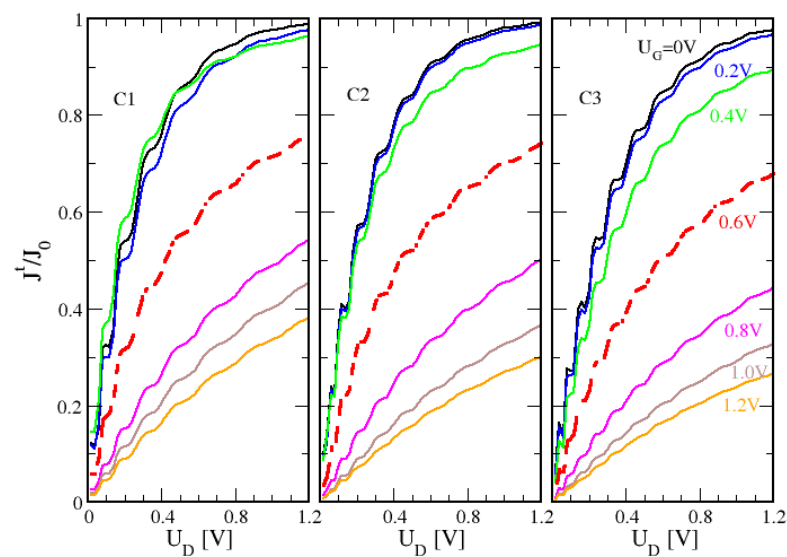
Figure 7. Ratio between the tunneling drain current J t and the total drain current J 0 vs. drain voltage U D for C1 ( left ), C2 ( middle ) and C3 ( right ) at T = 298 K. In the OFF-state, U G = 0 V (black), = 0.6 (red, dashed) and in the ON-state U 0.2 V (blue), 0.4 V (green), at threshold U th G (magenta), 1.0 V (brown) and 1.2 V